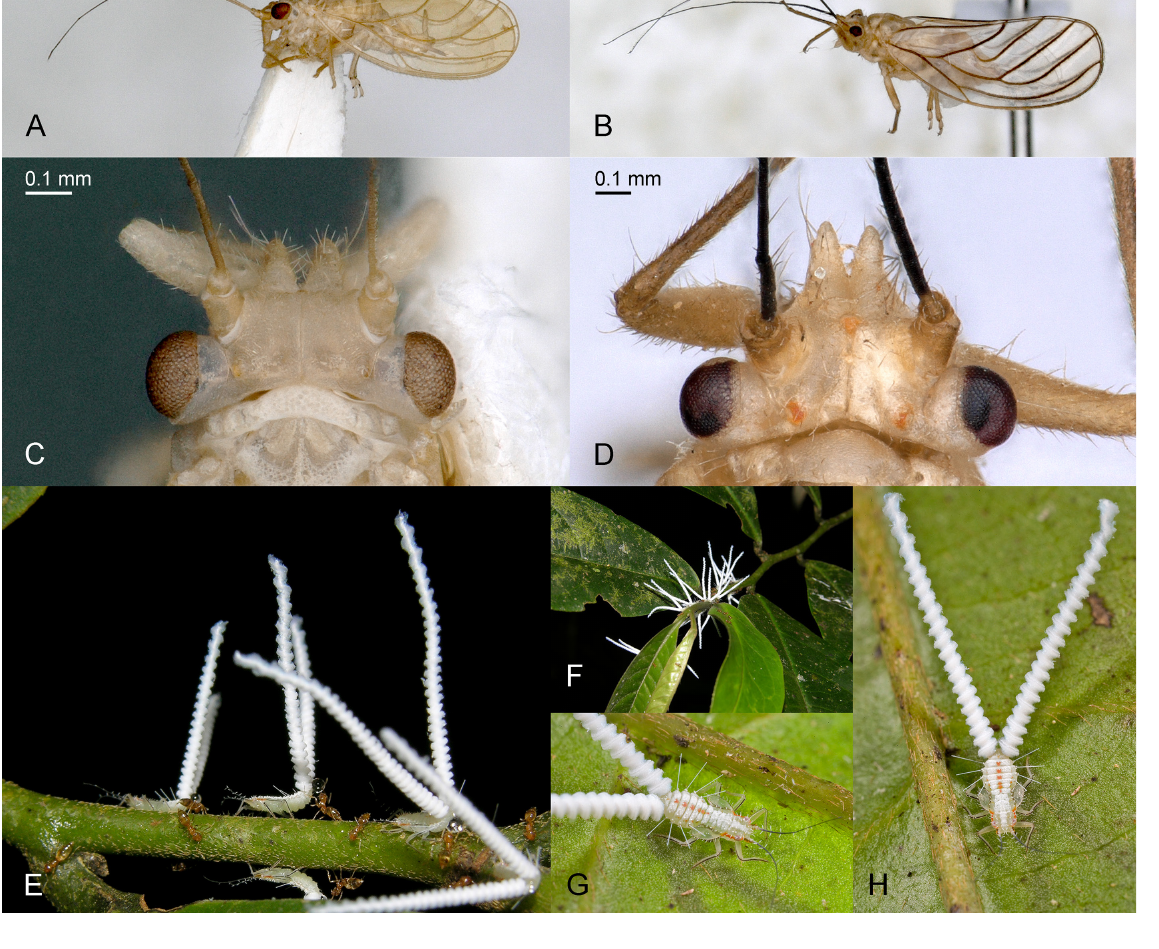
Fig. 6. Ciriacreminae Enderlein, 1910: Hollisiana spp. A, C . Hollisiana caradociforma (Brown